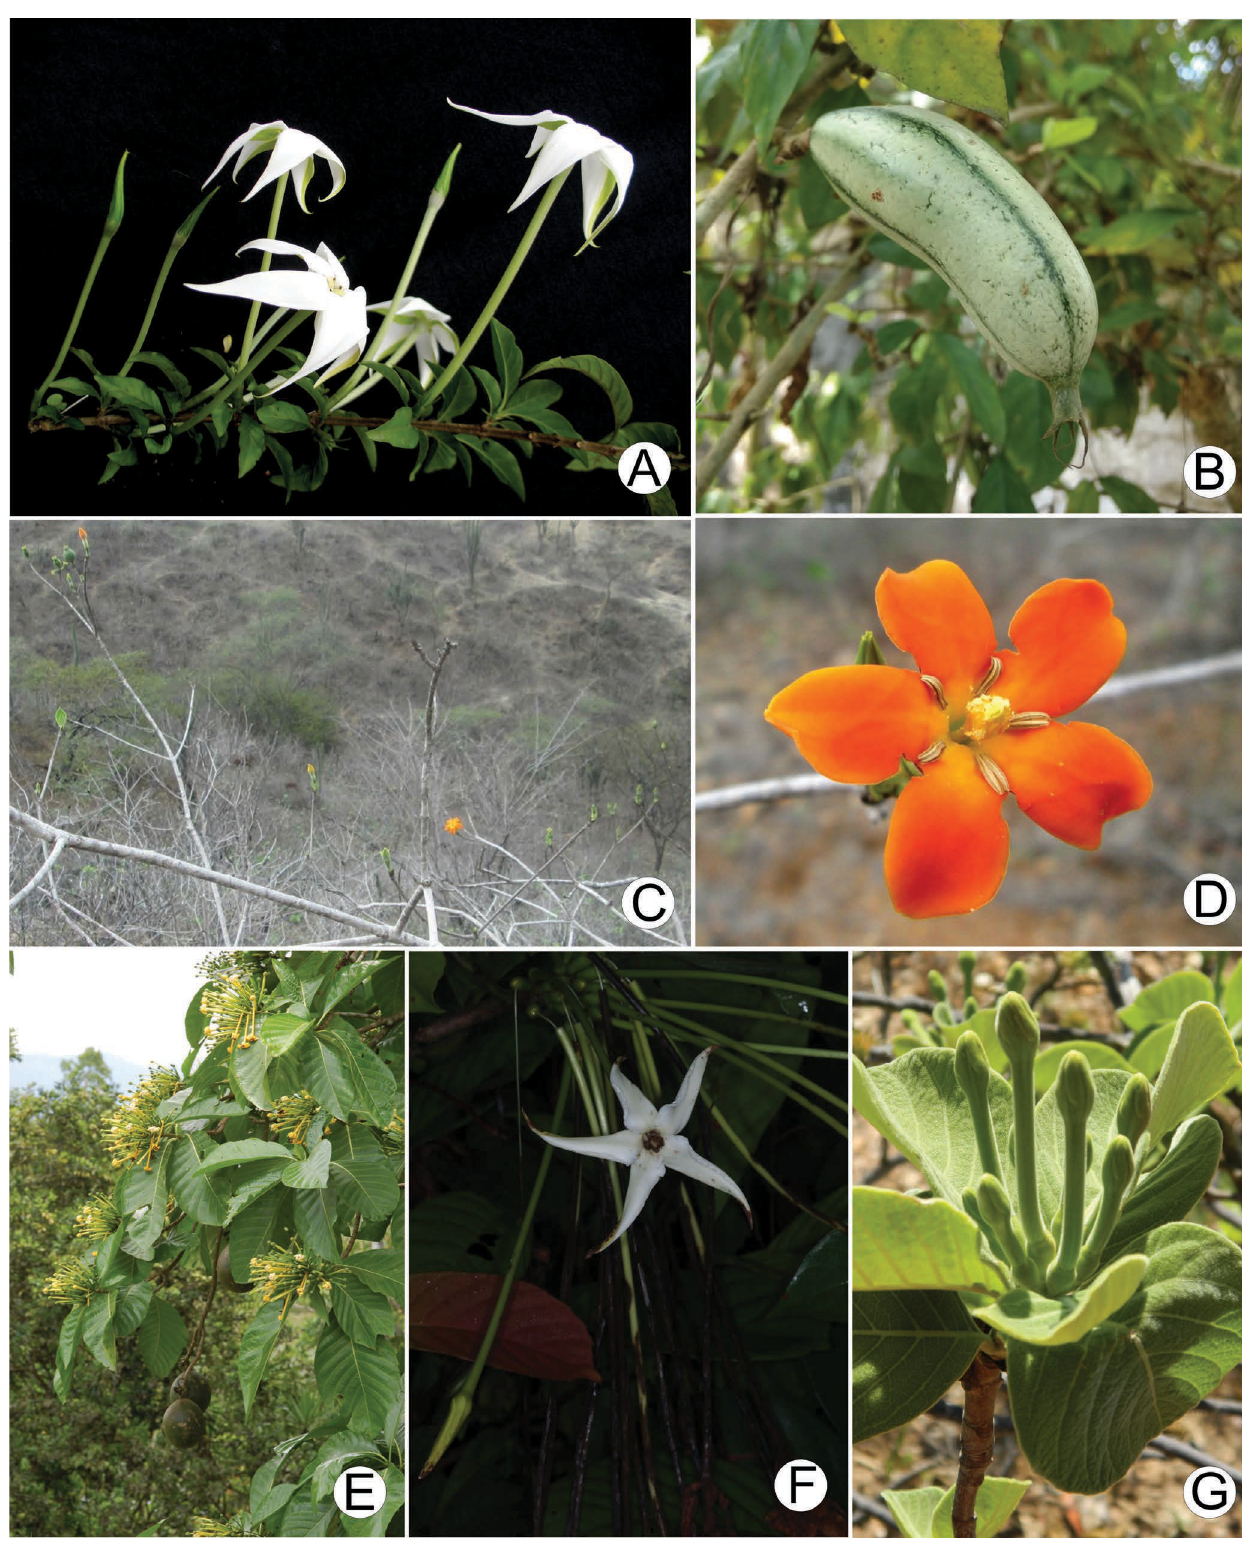
Figure 2 – Selected species of the Rosenbergiodendron clade. A – B . Rosenbergiodendron formosum , flowers (lateral view) and fruit. C – D . Sphinctanthus aurantiacus , habit and flower. E . Tocoyena pittieri ( T. pittieri group), inflorescences, flowers, and fruits. F . Tocoyena guianensis ( T. guianensis group) inflorescence and flower. G . Tocoyena formosa (core Tocoyena ), inflorescence and flower buds, lateral view. Photographs by André Benedito (A), Eduardo Salazar (B), Jorge Zapata (C–D), Barry Hammel (E), Hervé Galliffet (F), and Rodrigo Borges